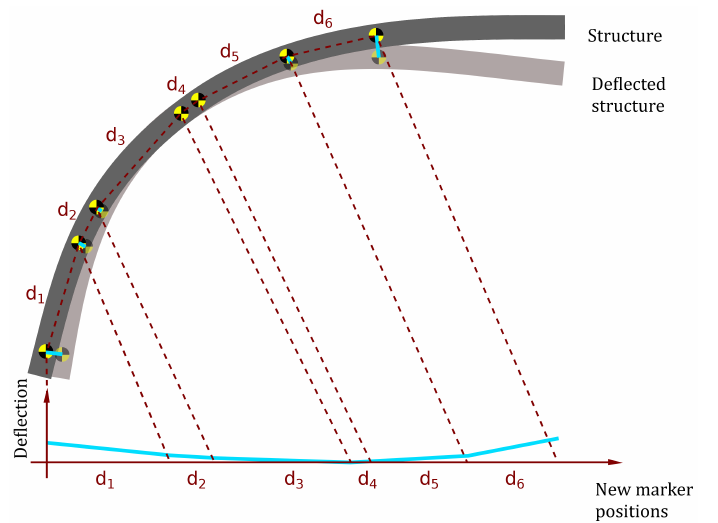
Figure 1. Illustration of the AMS method in practice. The non-beam structure is deflected (e.g., due to damage presence). The differences in deflection for the respective markers are mapped to a new set of coordinates. The Euclidean distances between markers are